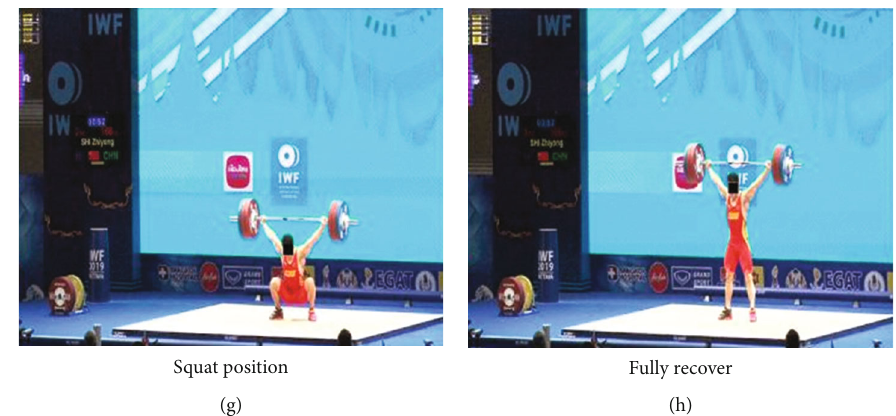
Figure 2: The feature pictures of each phase of snatch.